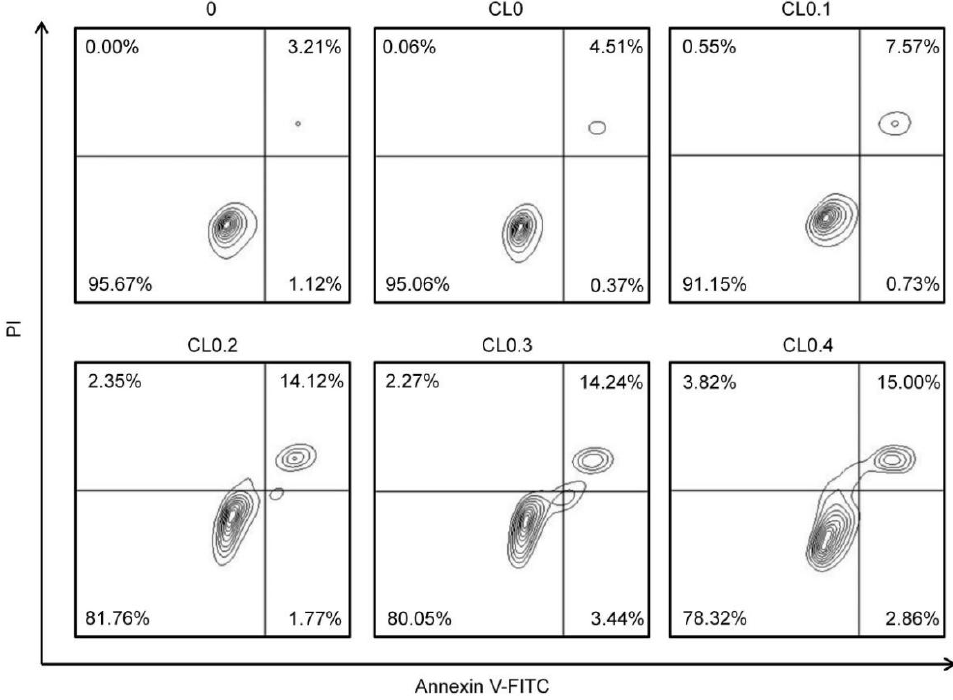
Figure 6. Flow cytometry analysis results of NIH 3T3 cells after treatment with the culture medium (control) or various concentrations of CLs (400 μg/mL) for 5 h. Before analysis, the cells were stained with annexin V-FITC and PI.